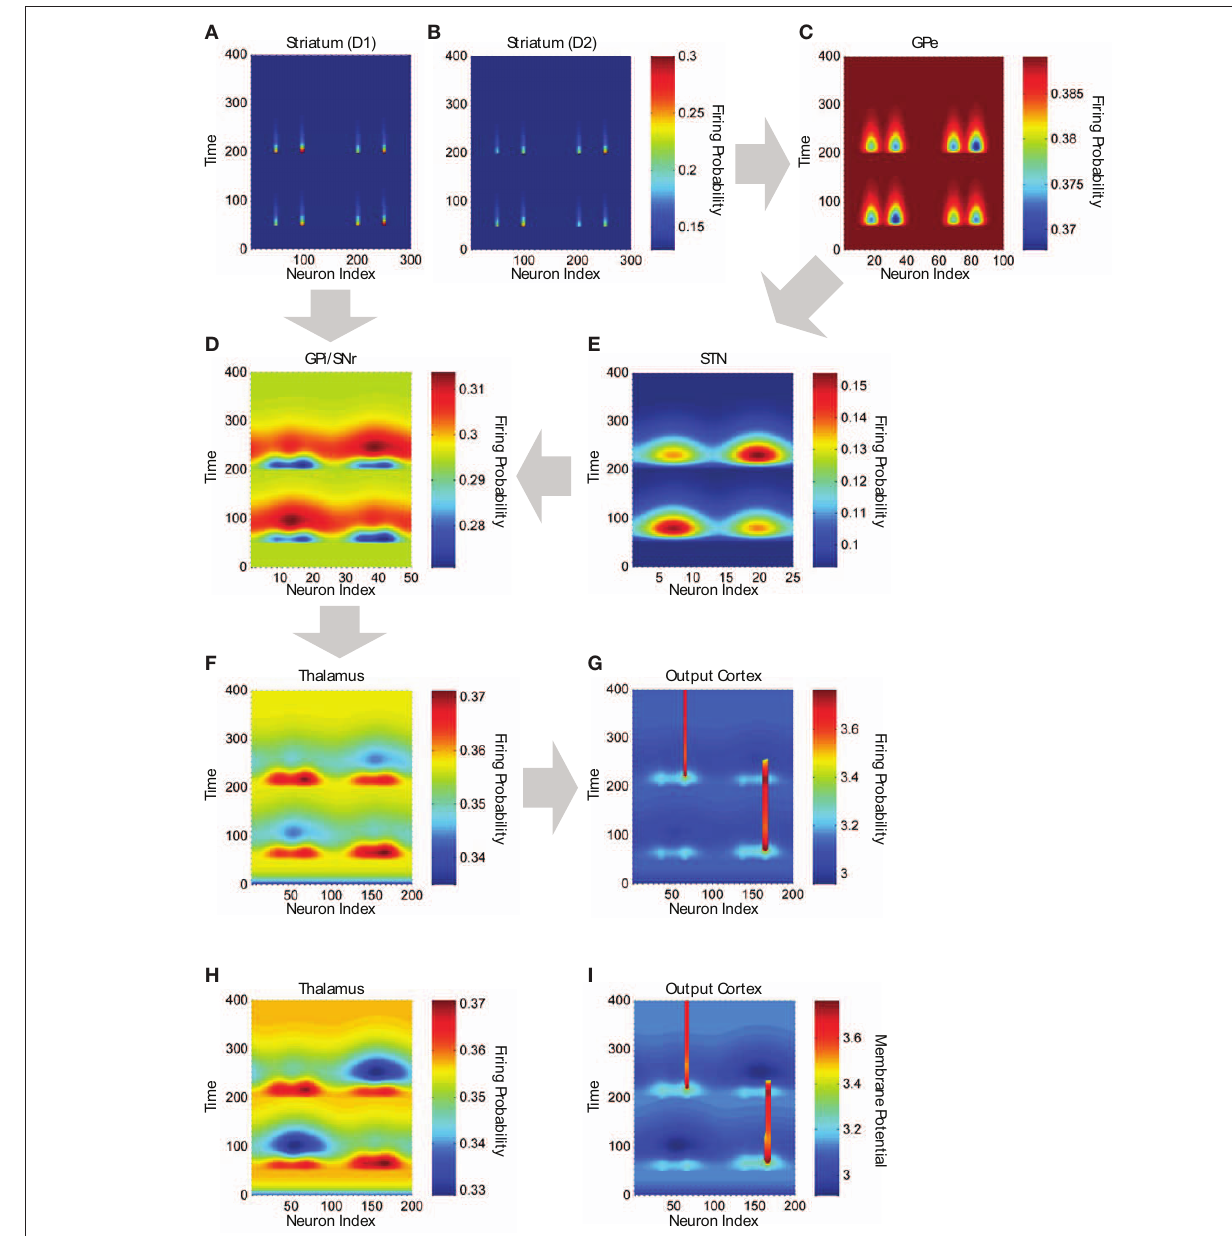
MSNs (blue troughs) and excitatory input from STN (red peaks). (e) Firing frequency of STN neurons ( n = 25), which receive convergent inhibitory input from GPe (red peaks represent lowest inhibition). (F) Firing frequency of thalamic neurons ( n = 200) in the simulation using only positive responsibility signals. (g) Membrane potential of neurons in the output region of the cortex ( n = 200) in the simulation using only positive responsibility signals. Vertical red bars represent persistent supra-threshold cortical depolarization maintained by self-feedback connections. (H) Firing frequency of thalamic neurons ( n = 200) in the simulation using both positive and negative responsibility signals. (i) Membrane potential of neurons in the output region of the cortex ( n = 200) in the simulation using both positive and negative responsibility signals. The blue troughs observed in the thalamic and cortical activity are deeper in the simulation using both positive and negative responsibility signals. Note: in (A,B) , we show only about one out of every six of the inactive MSNs, to make the active MSNs more visible in